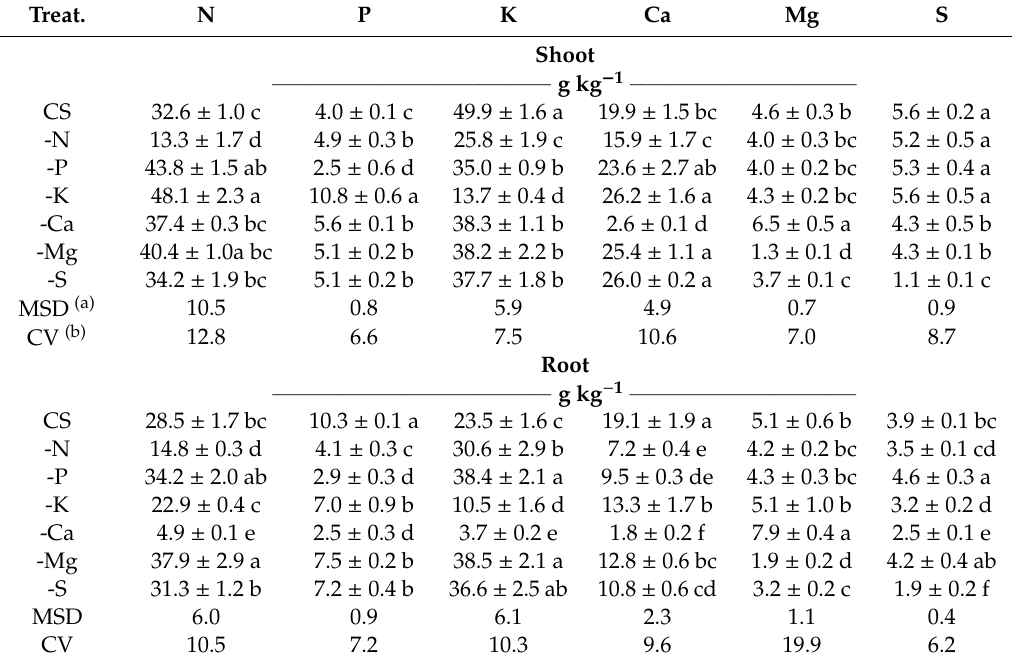
Table 3. Nutrient content in shoots and roots of broccoli ( Brassica oleracea var. italica L.) plants cultivated with a complete nutrient solution (CS) and with the omission of macronutrients.